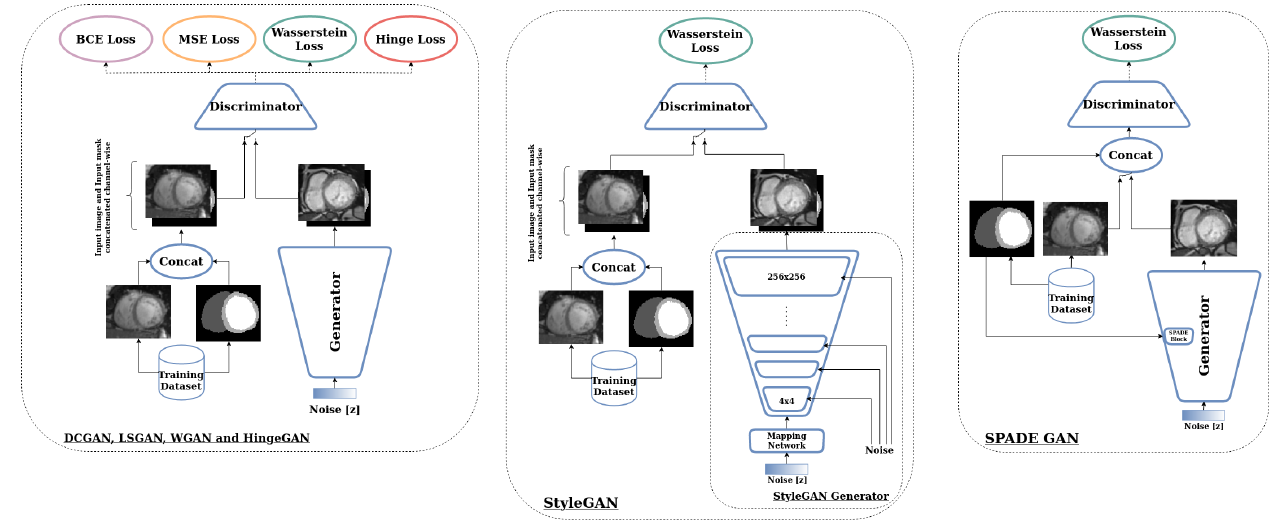
Figure 2. Architectures of the various GANs